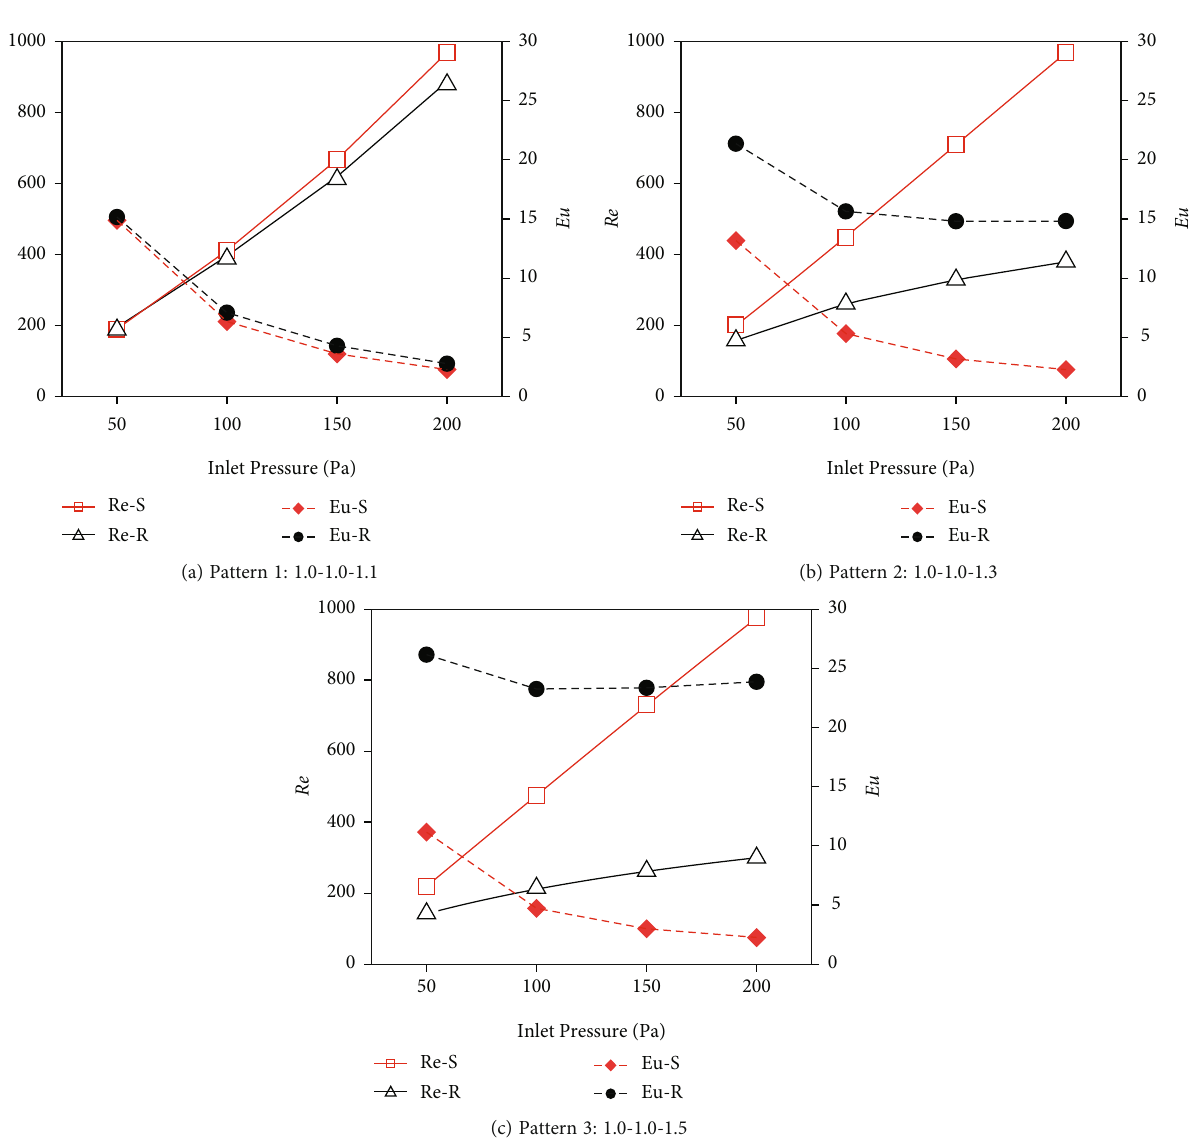
Figure 13: Evolution of Re and Eu ( D